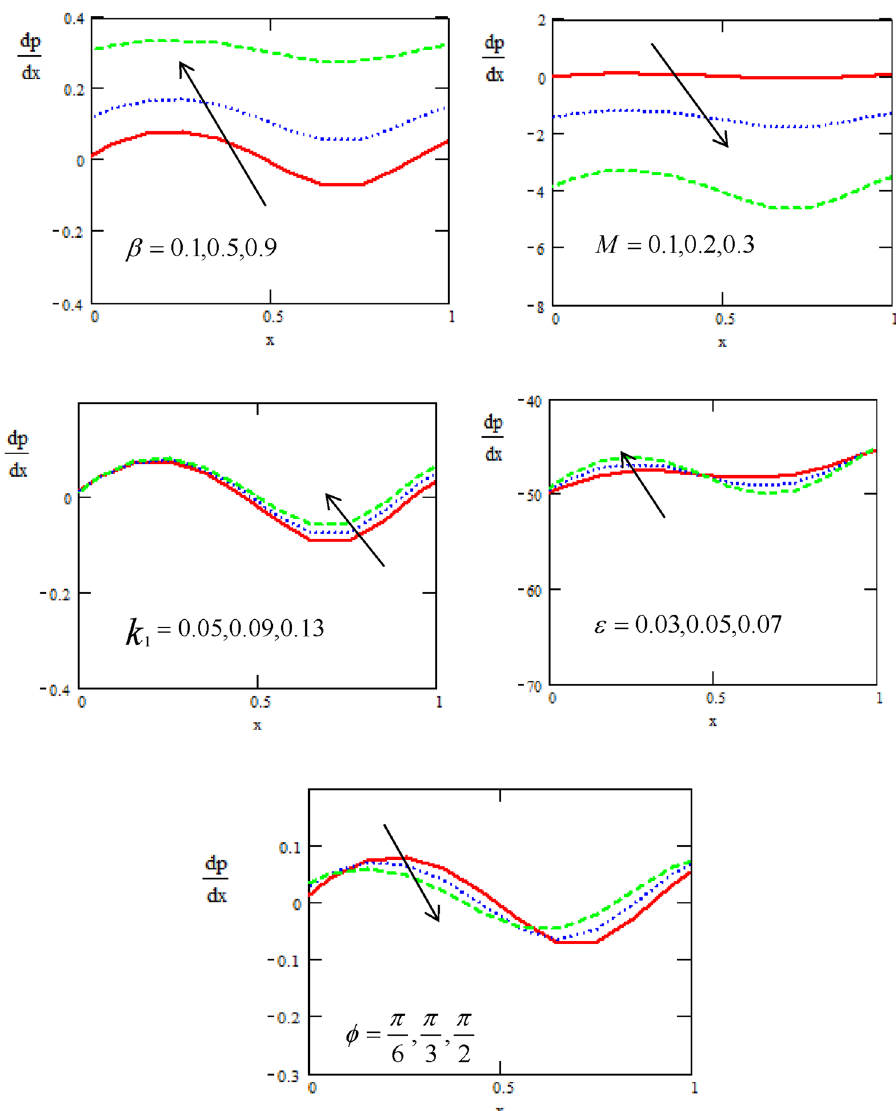
Figure 7. The gradient of Pressure concerning the axial-x with different values of ε , β , M , k 1 , ϕ